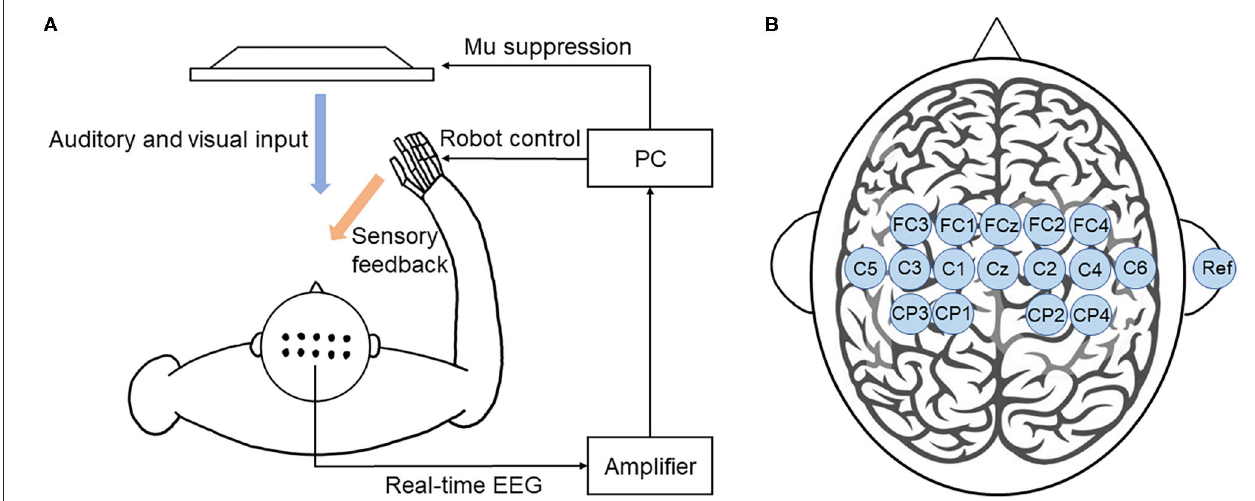
FIGURE 3 | BCI training system. (A) Illustration of the closed-loop system. This BCI system consists of an EEG amplifier collecting real-time EEG, a PC analyzing EEG signal and providing visual and auditory feedback, and a robot hand providing sensory feedback. (B) The location of EEG electrodes. There were 16 active electrodes placed on the motor and sensory area and a reference electrode placed on the right